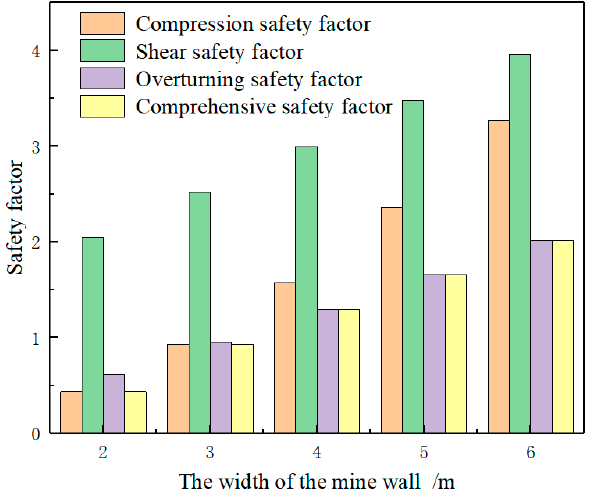
Figure 3. Relationship between safety factor and the width of the mine wall.